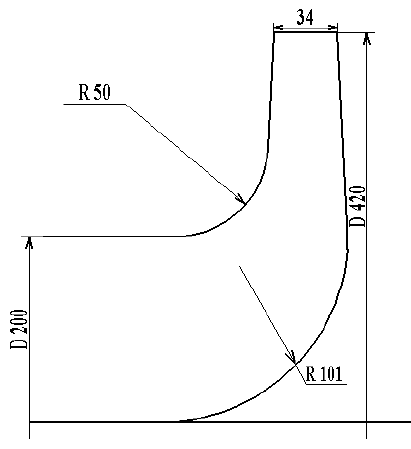
Figure 1. Two-dimensional model of the impeller.